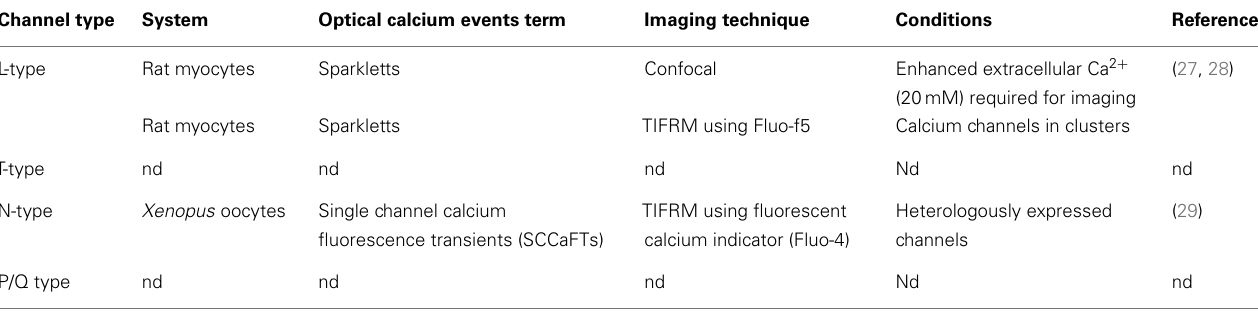
Table 1 |Voltage-gated calcium channel cohort activities that have been